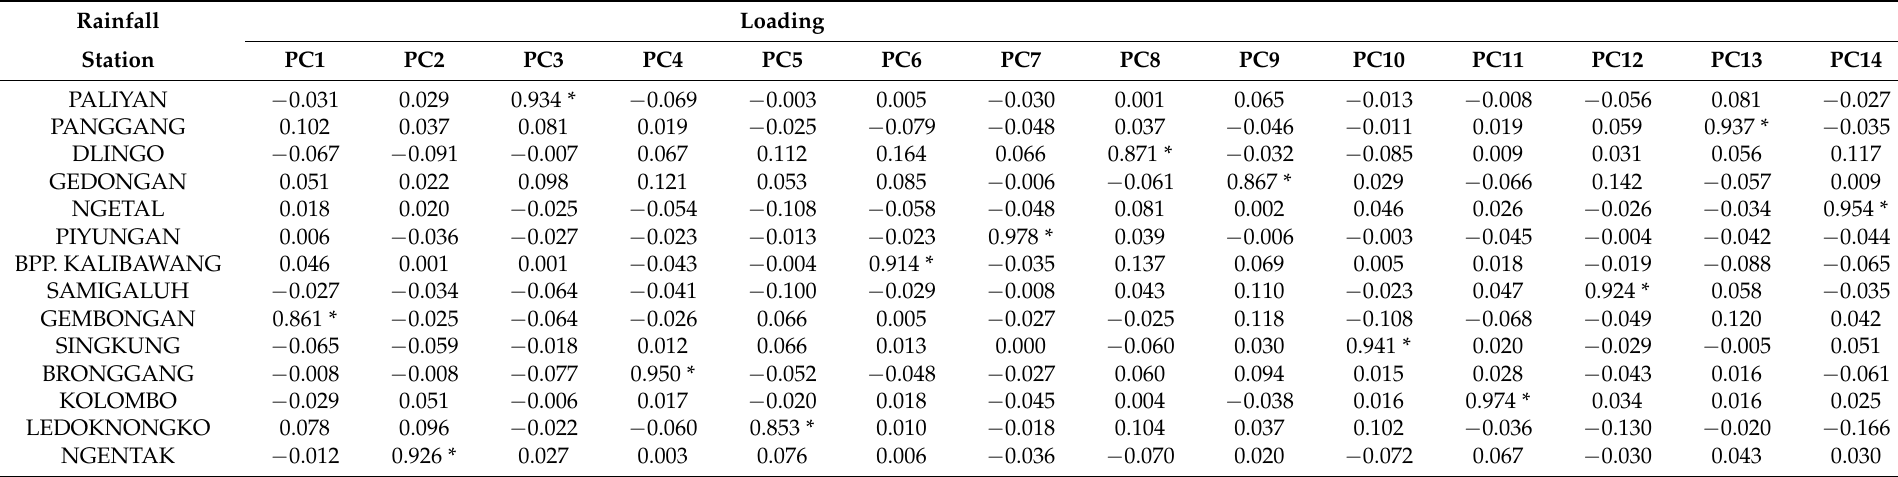
Table 6. Loadings for the first 14 PCs of the rainy season in Yogyakarta,